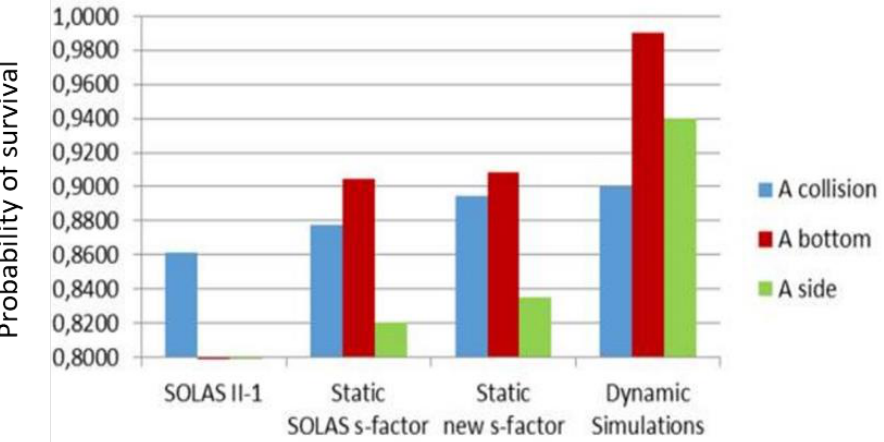
Figure 7. Comparison between static and time-domain simulations results — Ship C.